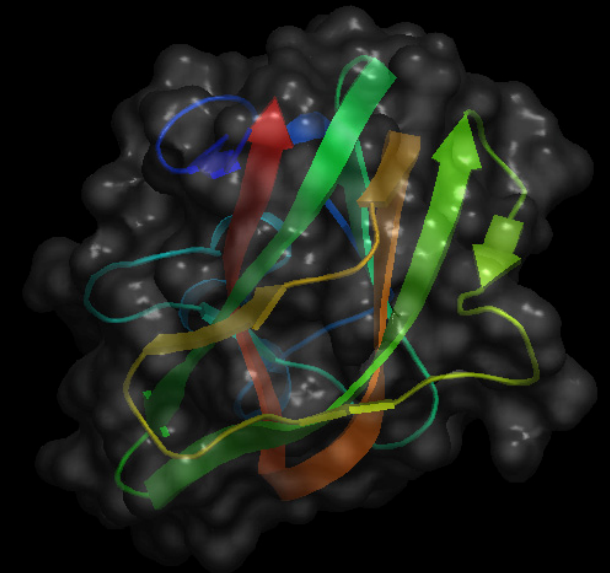
Figure 4. Schematic representation of the crystal structure of the C2 domain of bovine lactadherin at a resolution of 1.67 Å. The file with pdb ID 3bng was retrieved from protein data bank [16] and visualized with Open Astex Viewer maintaining the protein on a black background and representing the protein surface in grey with a 30% of